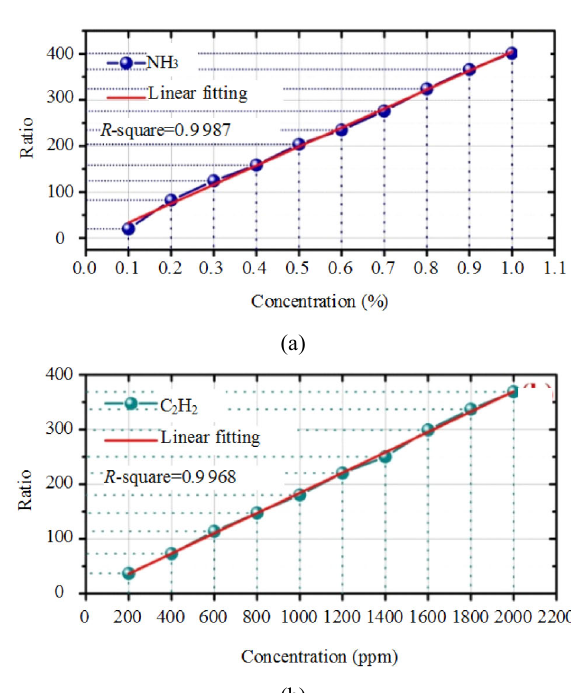
Fig. 10 Gas detection system concentration analysis: (a) NH 3 and (b) C 2 H 2